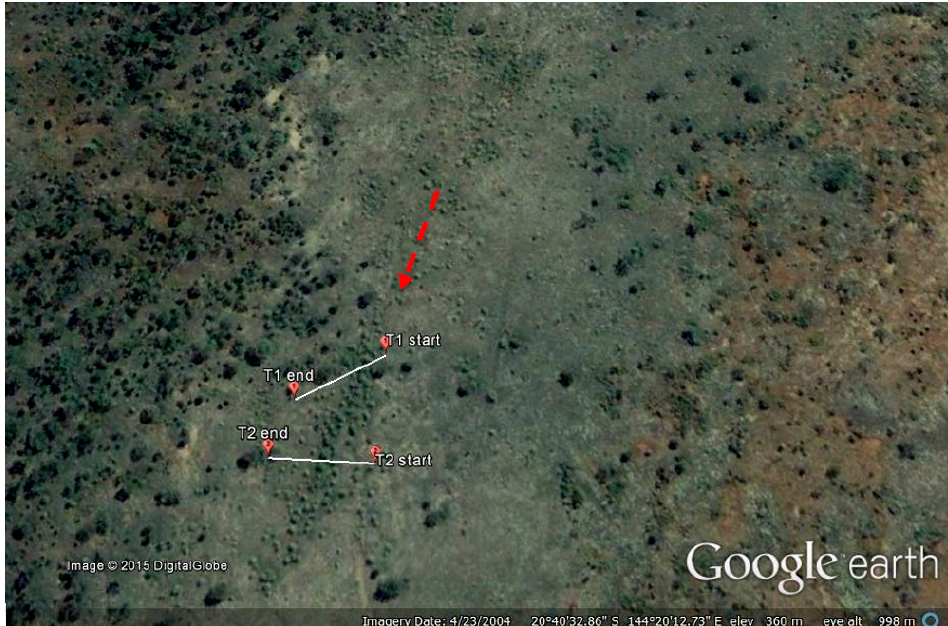
Figure 2. Transect orientation at Koon Kool Station. Transect lines are 50 m in length running in the general direction of east to west [15]. Red arrow shows the direction of travel of dieback front.